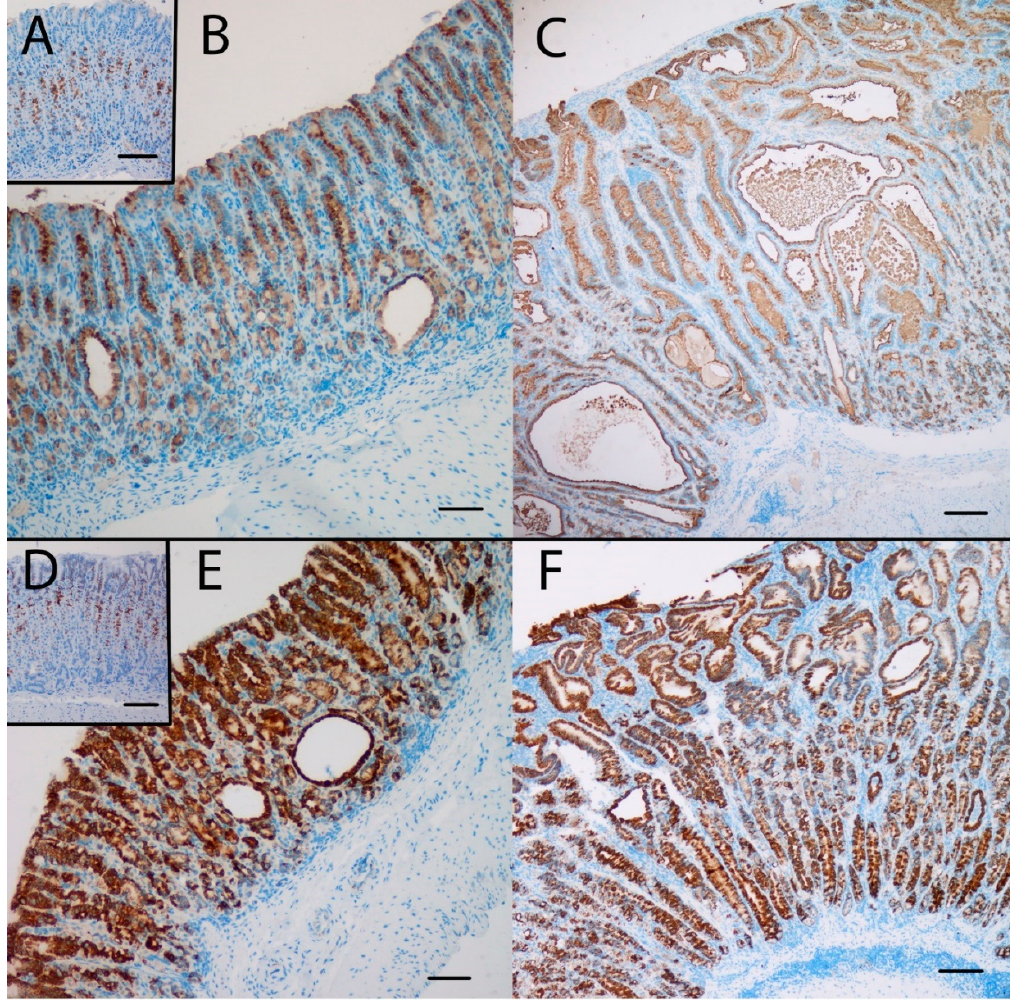
Figure 3. The SPEM marker clusterin was highly expressed at the protein ( A , B , C ) and the mRNA ( D , E , F ) level in the oxyntic mucosa of KO/PEG mice (C and F), compared to WT/PEG mice (A and D). Clusterin expression in KO mice was not affected by NTZ (B and E). Scare Bar = 100 µm.